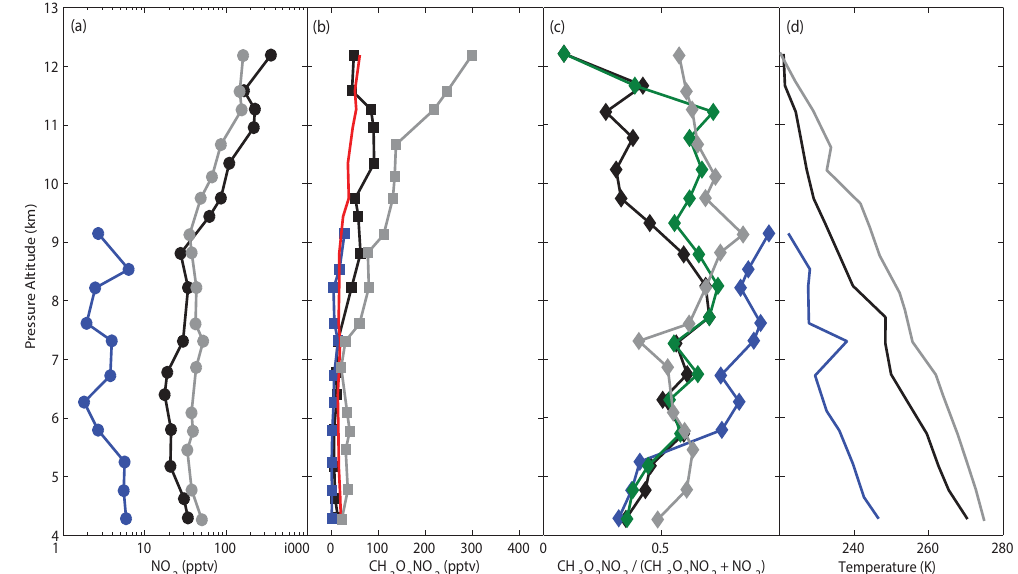
Figure 10. The median profile of (a) NO 2 , (b) CH 3 O 2 NO 2 , (c) CH 3 O 2 NO 2 /(NO 2 + CH 3 O 2 NO 2 ), and (d) temperature for ARCTAS-A (blue), DC-3 (black), and SEAC4RS (dark grey). The red line in (b) is the median limit of detection for S/N = 2, 60s for DC-3. The green line in (c) is the median CH 3 O 2 NO 2 /(NO 2 + CH 3 O 2 NO 2 ) in background air where NO x /NO y is less than 0.2 during DC-3.